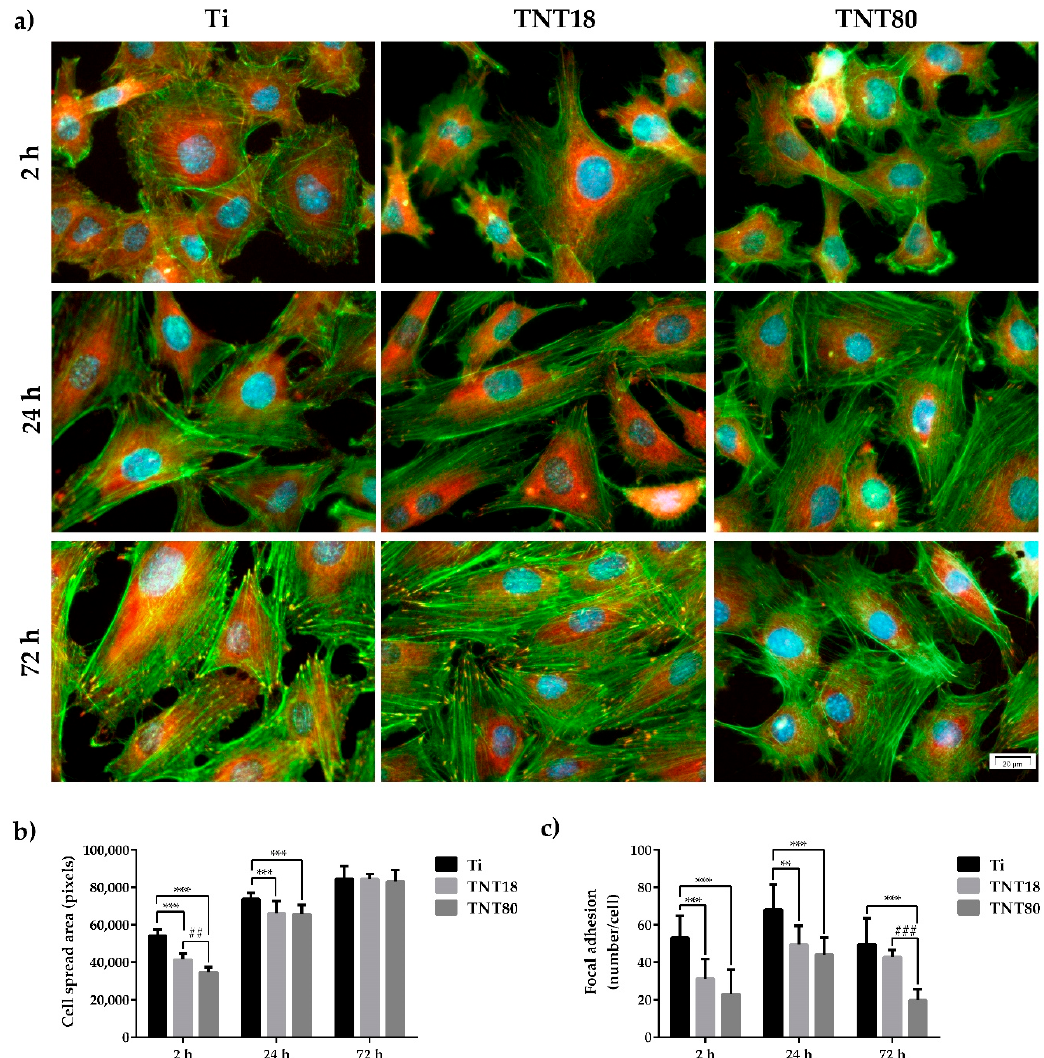
Figure 3. Cell adhesion, spreading and morphology at 2 h, 24 h and 72 h post-seeding. ( a ) Fluorescence micrographs used to assess adhesion and morphological characteristics of the MC3T3-E1 pre-osteoblasts maintained in contact with Ti, TNT18 and TNT80 surfaces. The cytoskeletal actin filaments were stained with phalloidin coupled with Alexa Fluor-488 (green); vinculin was labeled with anti-vinculin primary antibody and secondary antibody coupled with Alexa Fluor-546 (red); the nuclei were stained with DAPI (blue); ( b ) Quantitative analysis of cell spread area. Results are presented as means ± SD (n = 10 cells, *** p < 0.001 compared with Ti; ## p < 0.01 compared with TNT18); ( c ) Quantification of focal adhesions. Results are presented as means ± SD (n = 10 cells, ** p < 0.01, *** p < 0.001 compared with Ti; ### p < 0.001 compared with TNT18).